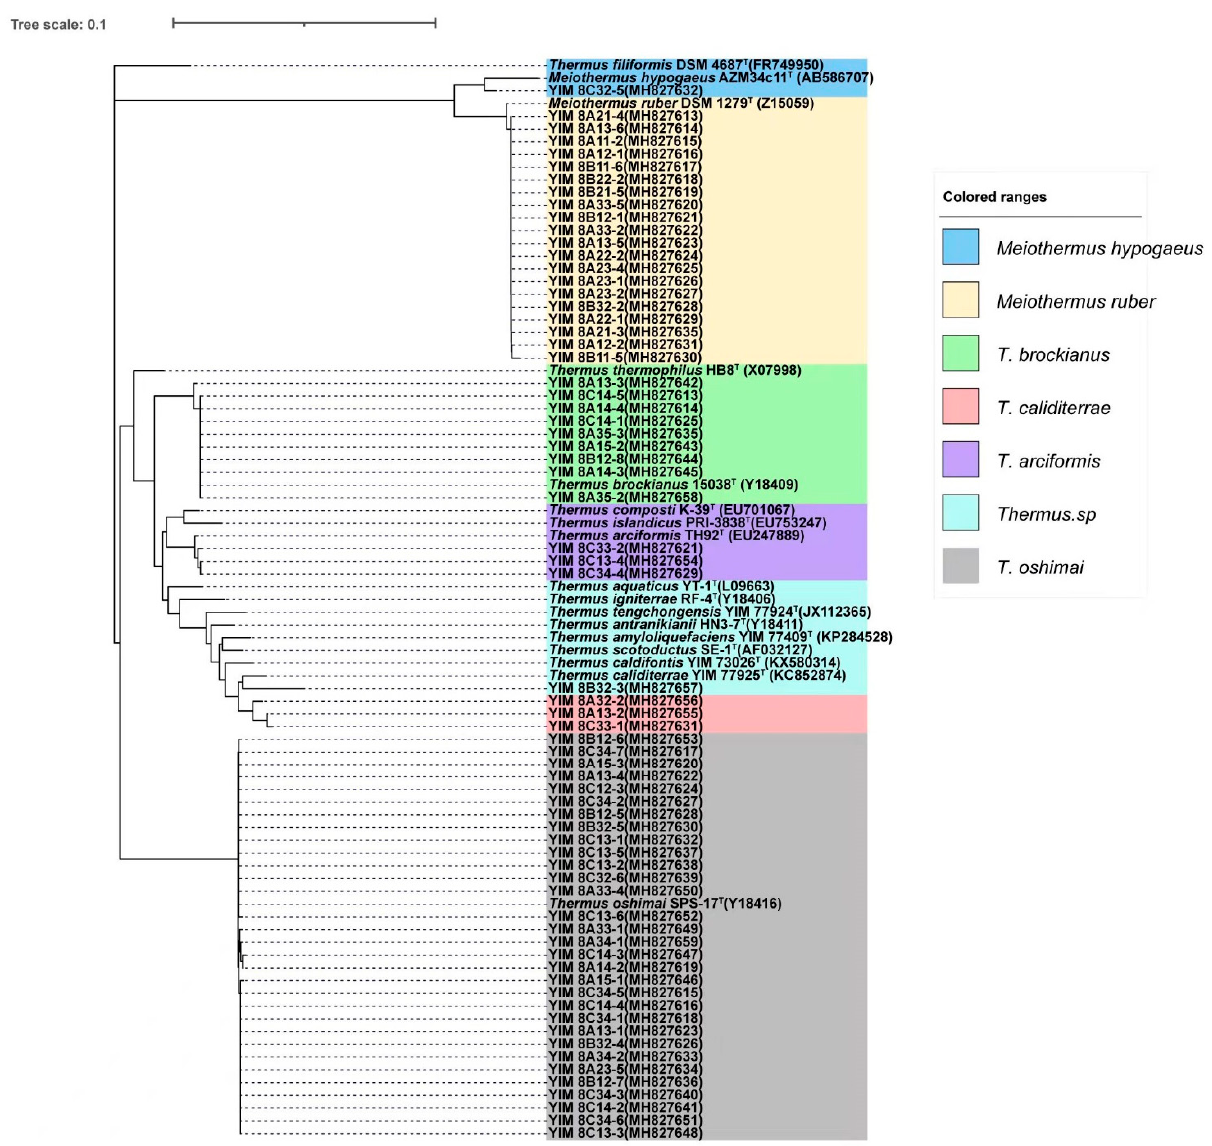
Figure 3. The phylogenetic tree for the culturable Thermus strains in the Baoshan geothermal region. Numbers at nodes indicate bootstrap values (>50%) based on a neighbor-joining analysis of 1000 resampled datasets. The vertical scale bar in the middle represents 0.1 substitutions per nucleotide position.